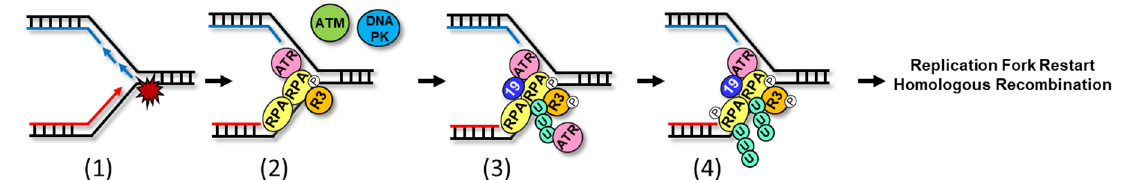
Figure 2. Ubiquitylation on the RPA-ssDNA platform during Replication Stress. ( 1 ) Fork uncoupling leads to RPA-ssDNA production which is constitutively associated with the RFWD3 (R3) ubiquitin ligase; ( 2 ) RPA hyper-phosphorylation by ATR, ATM and DNA-PK enhances the recruitment of PRP19 (19); ( 3 ) PRP19 and RFWD3 poly-ubiquitylate the RPA complex. K63-linked chains help tether ATR-ATRIP to RPA-ssDNA; ( 4 ) this produces a feed-forward loop that results in the spreading of RPA phosphorylation and ubiquitylation across RPA-ssDNA filaments. These modifications stimulate RSR signaling, fork restart and homologous